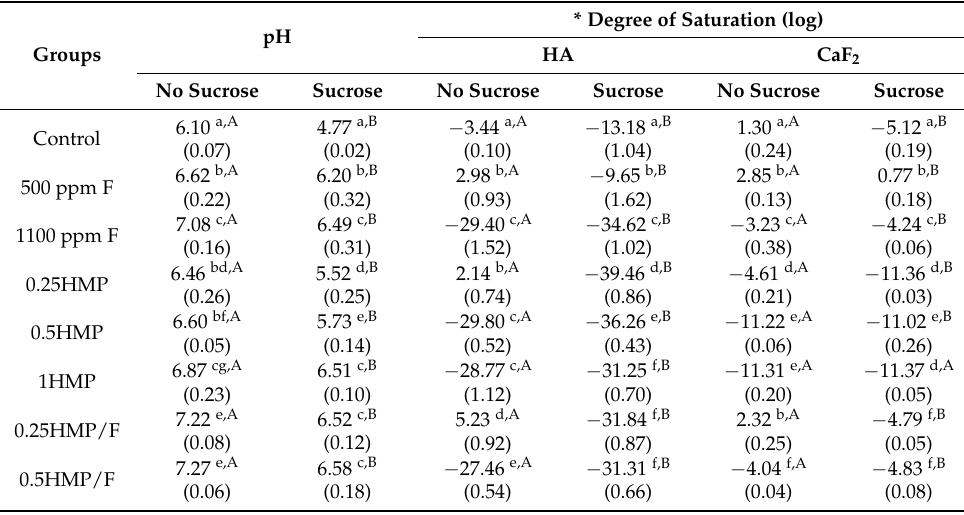
Table 1. Mean (SD) pH of the biofilm and degree of saturation in relation to hydroxyapatite (HA) and calcium fluoride (CaF 2 ) in the biofilm fluid, before and after exposure to sucrose.